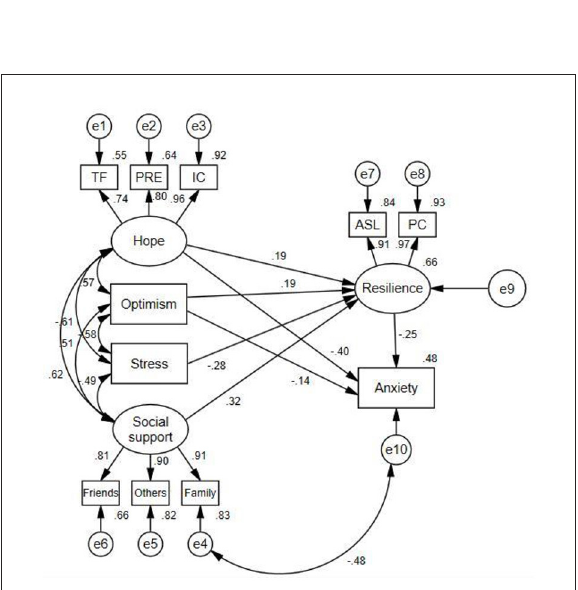
FIGURE1 Path diagram for the hypothetical model. TF, temporality and future; PRE, positive readiness and expectancy; IC, interconnectedness; PC, personal competence; ASL, acceptance of self and